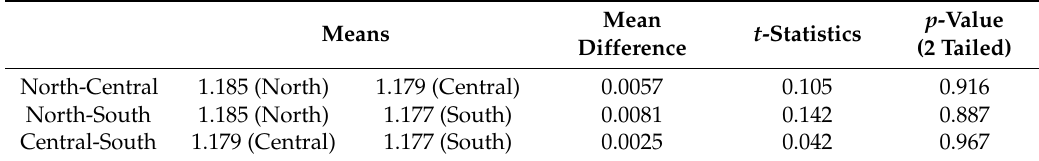
Table 4. A comparison of the mean number of agriculture-related courses studied in Alabama’s High schools across the three regions.